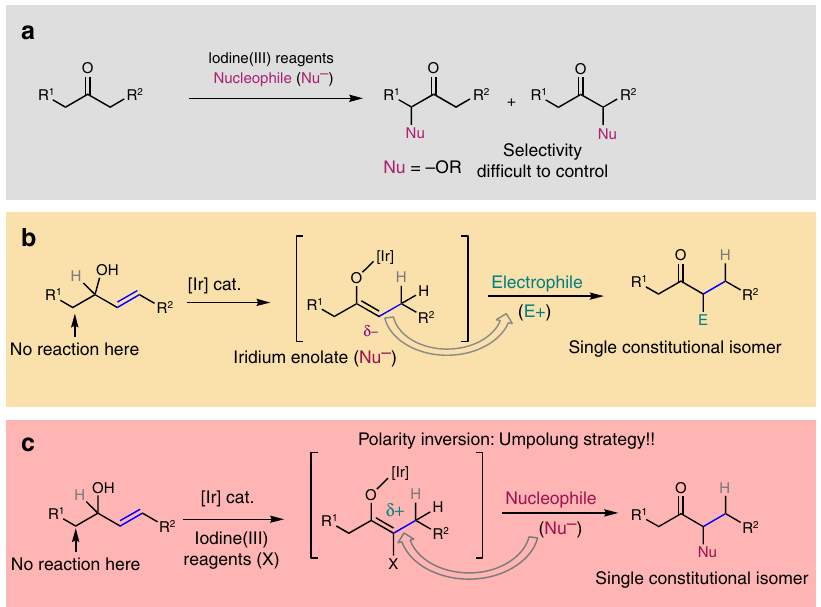
Fig. 1 Synthesis of α -substituted carbonyl compounds. a α -Functionalization of ketones through umpolung reactions. b Isomerization/functionalization of allylic alcohols with electrophiles. c Our approach: Isomerization/umpolung functionalization of allylic